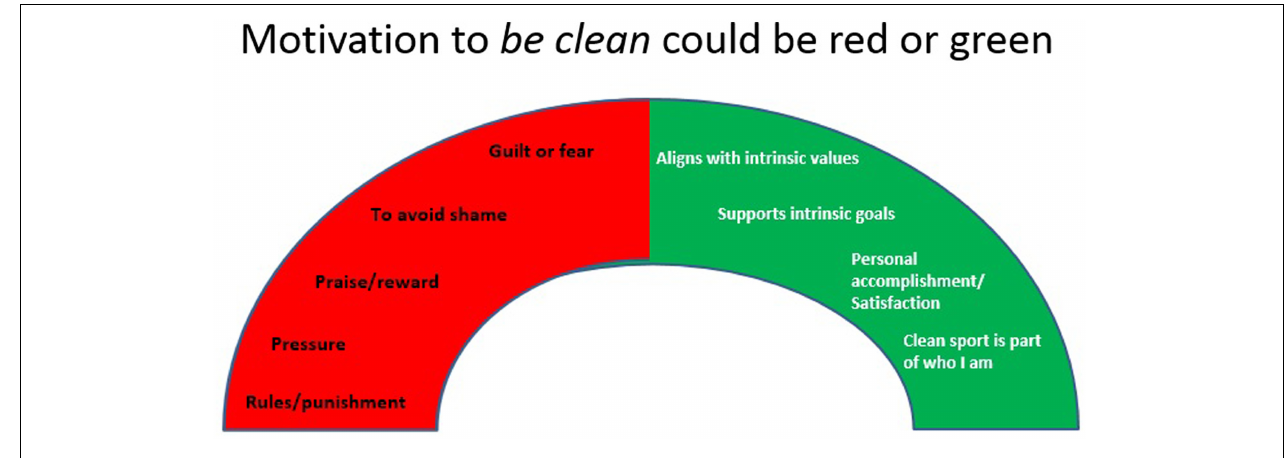
FIGURE 1 | Motivation